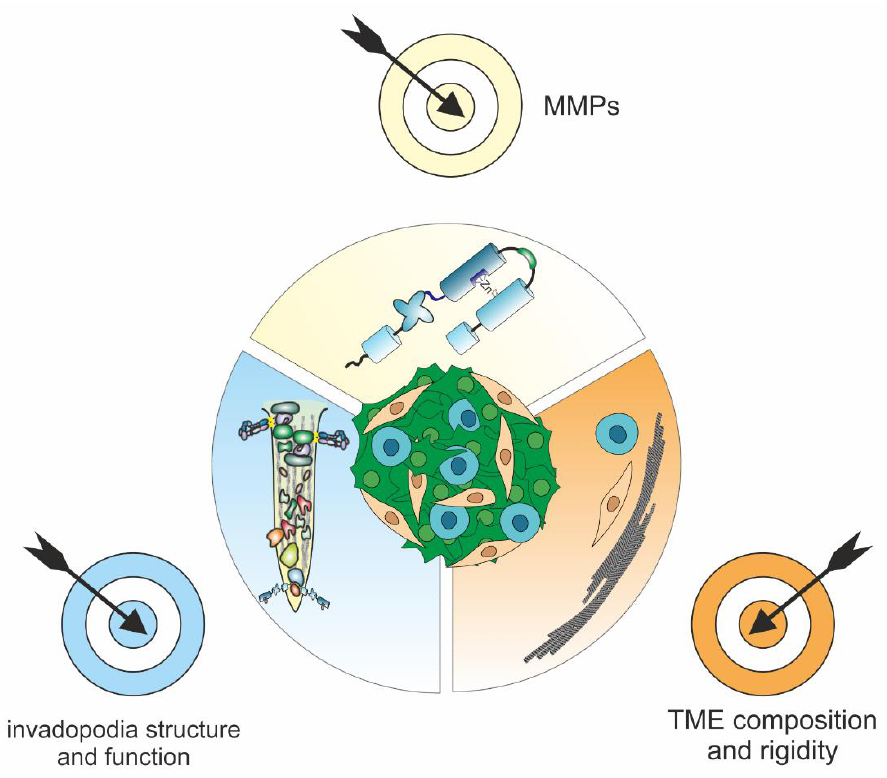
Figure 8. Possible approaches to inhibit metastasis. In addition to MMP inhibitors, therapeutic approaches that aim at the structure and function of invadopodia or at the TME with its increased matrix rigidity are conceivable to inhibit metastasis.